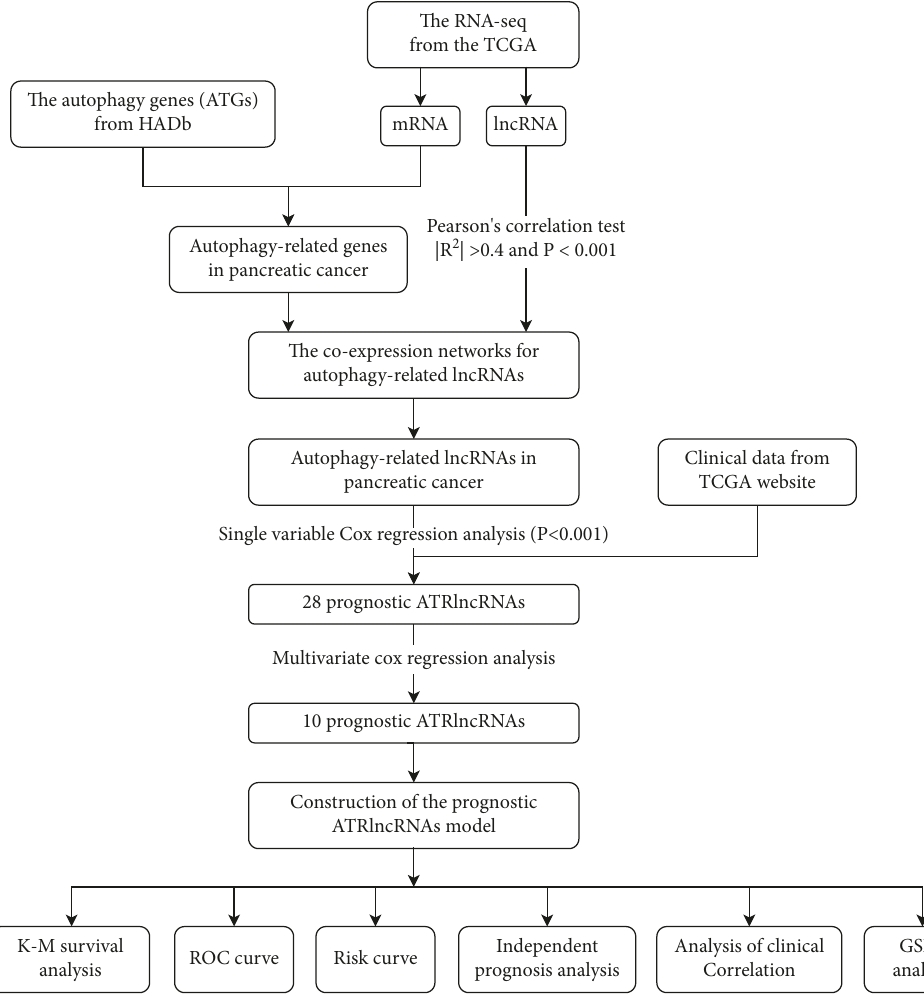
Figure 1: The workflow of this